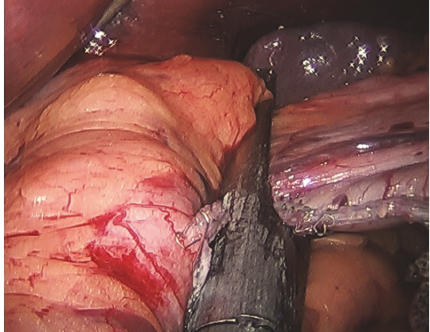
Figure 4: Final stapler loads using 3.5 mm staple height (Echelon Blue cartridge) without reinforcement material, angled to the left of the fat pad.